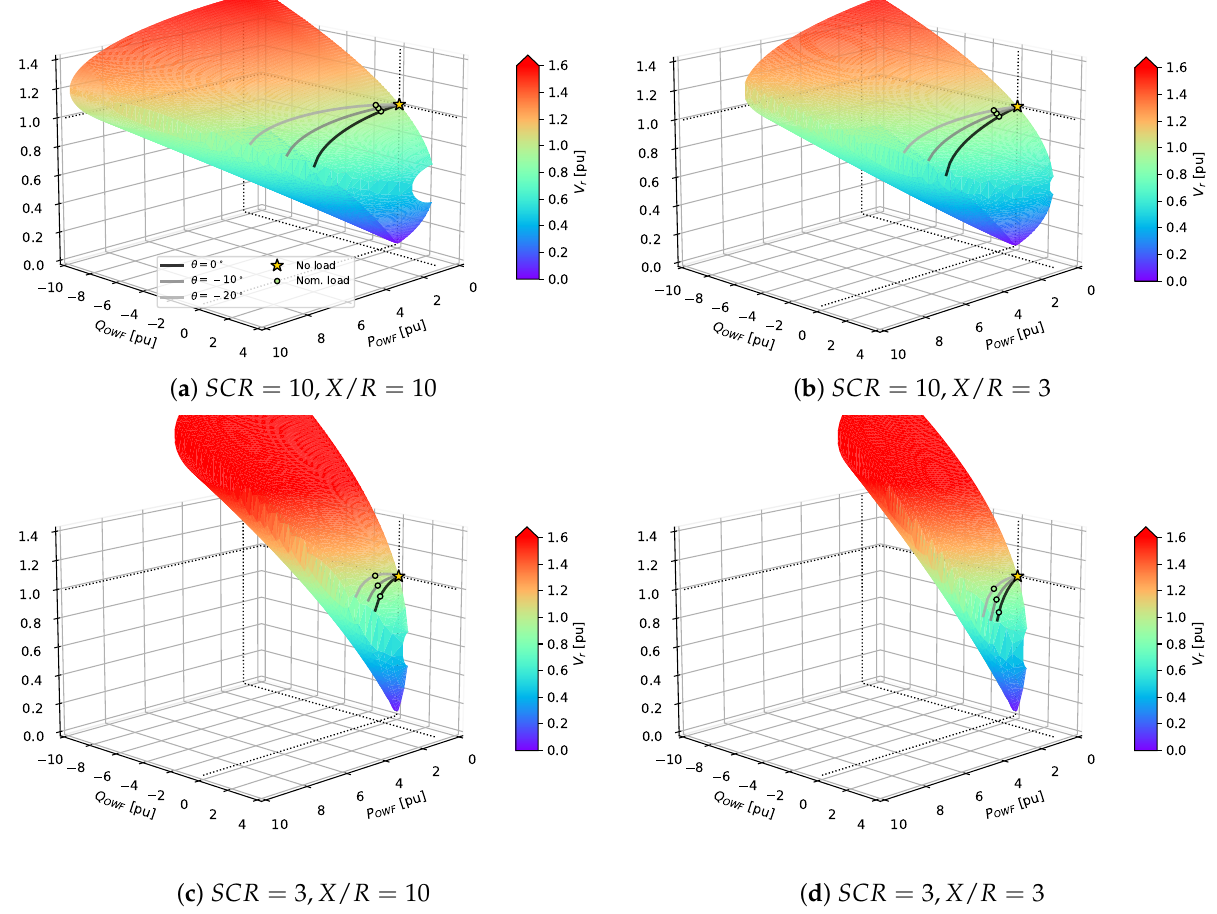
Figure 5. The feasible solution space F when expanding the PQV surfaces by solving (7). The 2D version is found in Figure